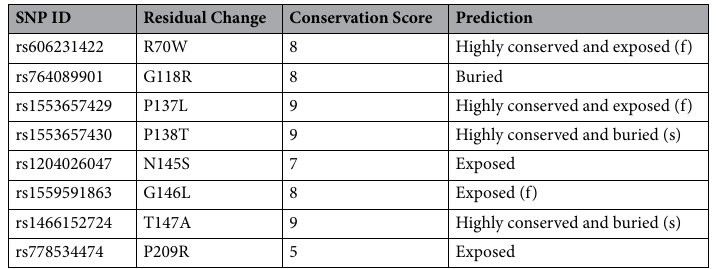
Table 3. Consurf results showing conservation scores of deleterious nsSNPs in CTLA4.